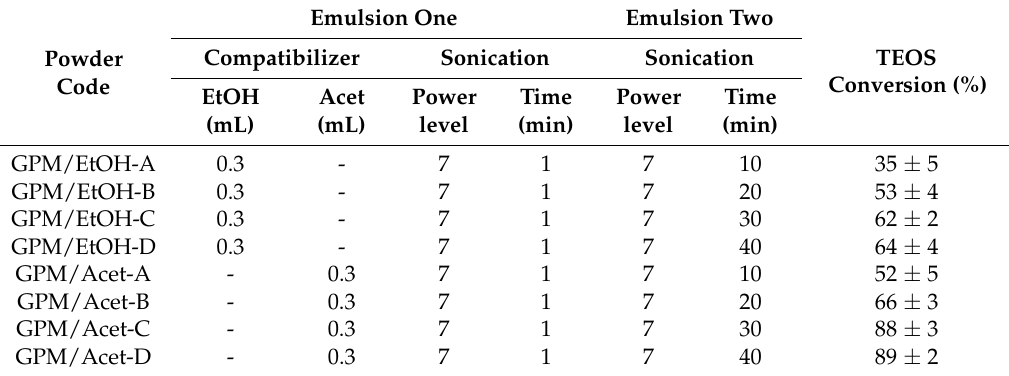
Table 3. The effect of the sonication time of emulsion two on the TEOS conversion. Aqueous solution was aged for four days in each case; all of the other synthesis parameters are provided in Table